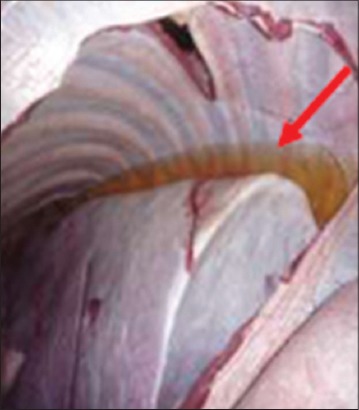
Straw colour fluid in thoracic region.